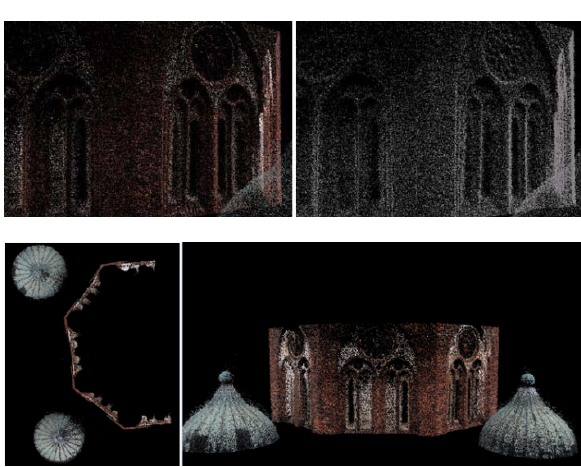
Figure 10. Detailed views of the SURE-point cloud of the tower (view from